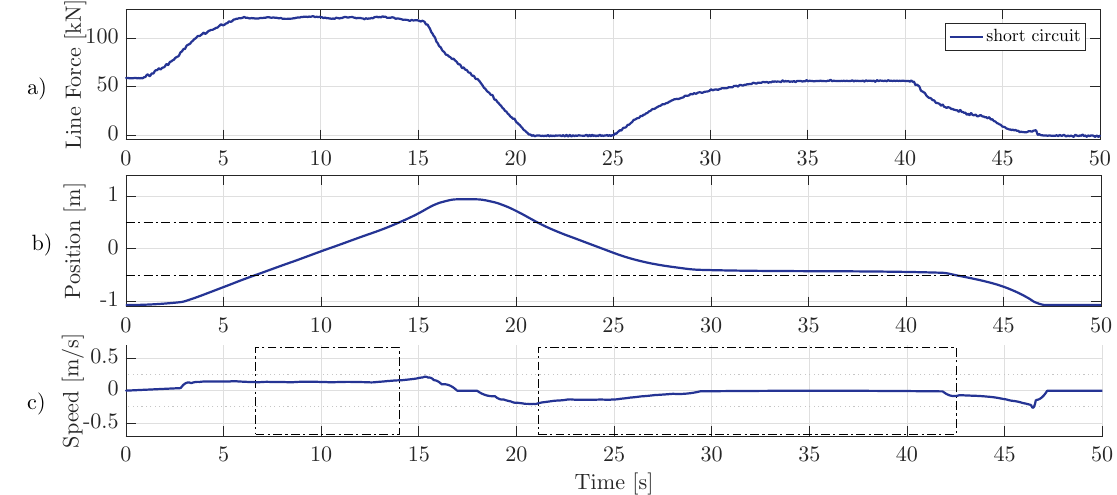
Figure 4. Measured line force ( a ), translator position ( b ) and translator speed ( c ) for the short circuit case during the high speed stroke. Dotted areas mark out full active